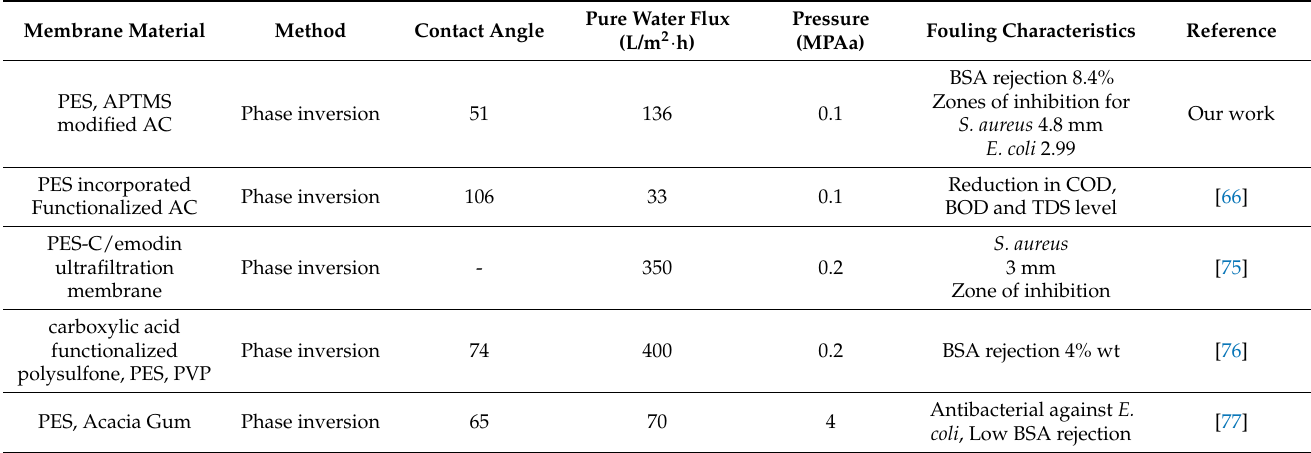
Table 5. Ultrafiltration mechanism of membranes reported in literature.